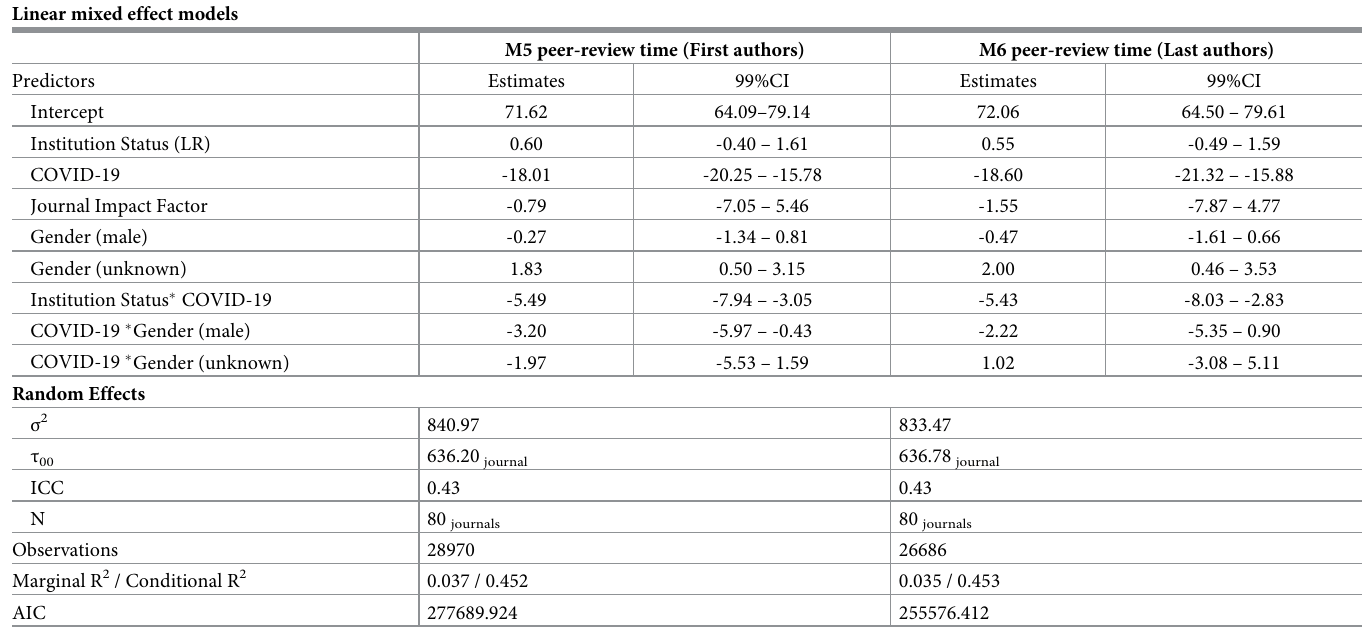
Table 2. Mixed linear regression models predicting the moderating effect of the COVID-19 topic on peer-review duration. Linear mixed effect